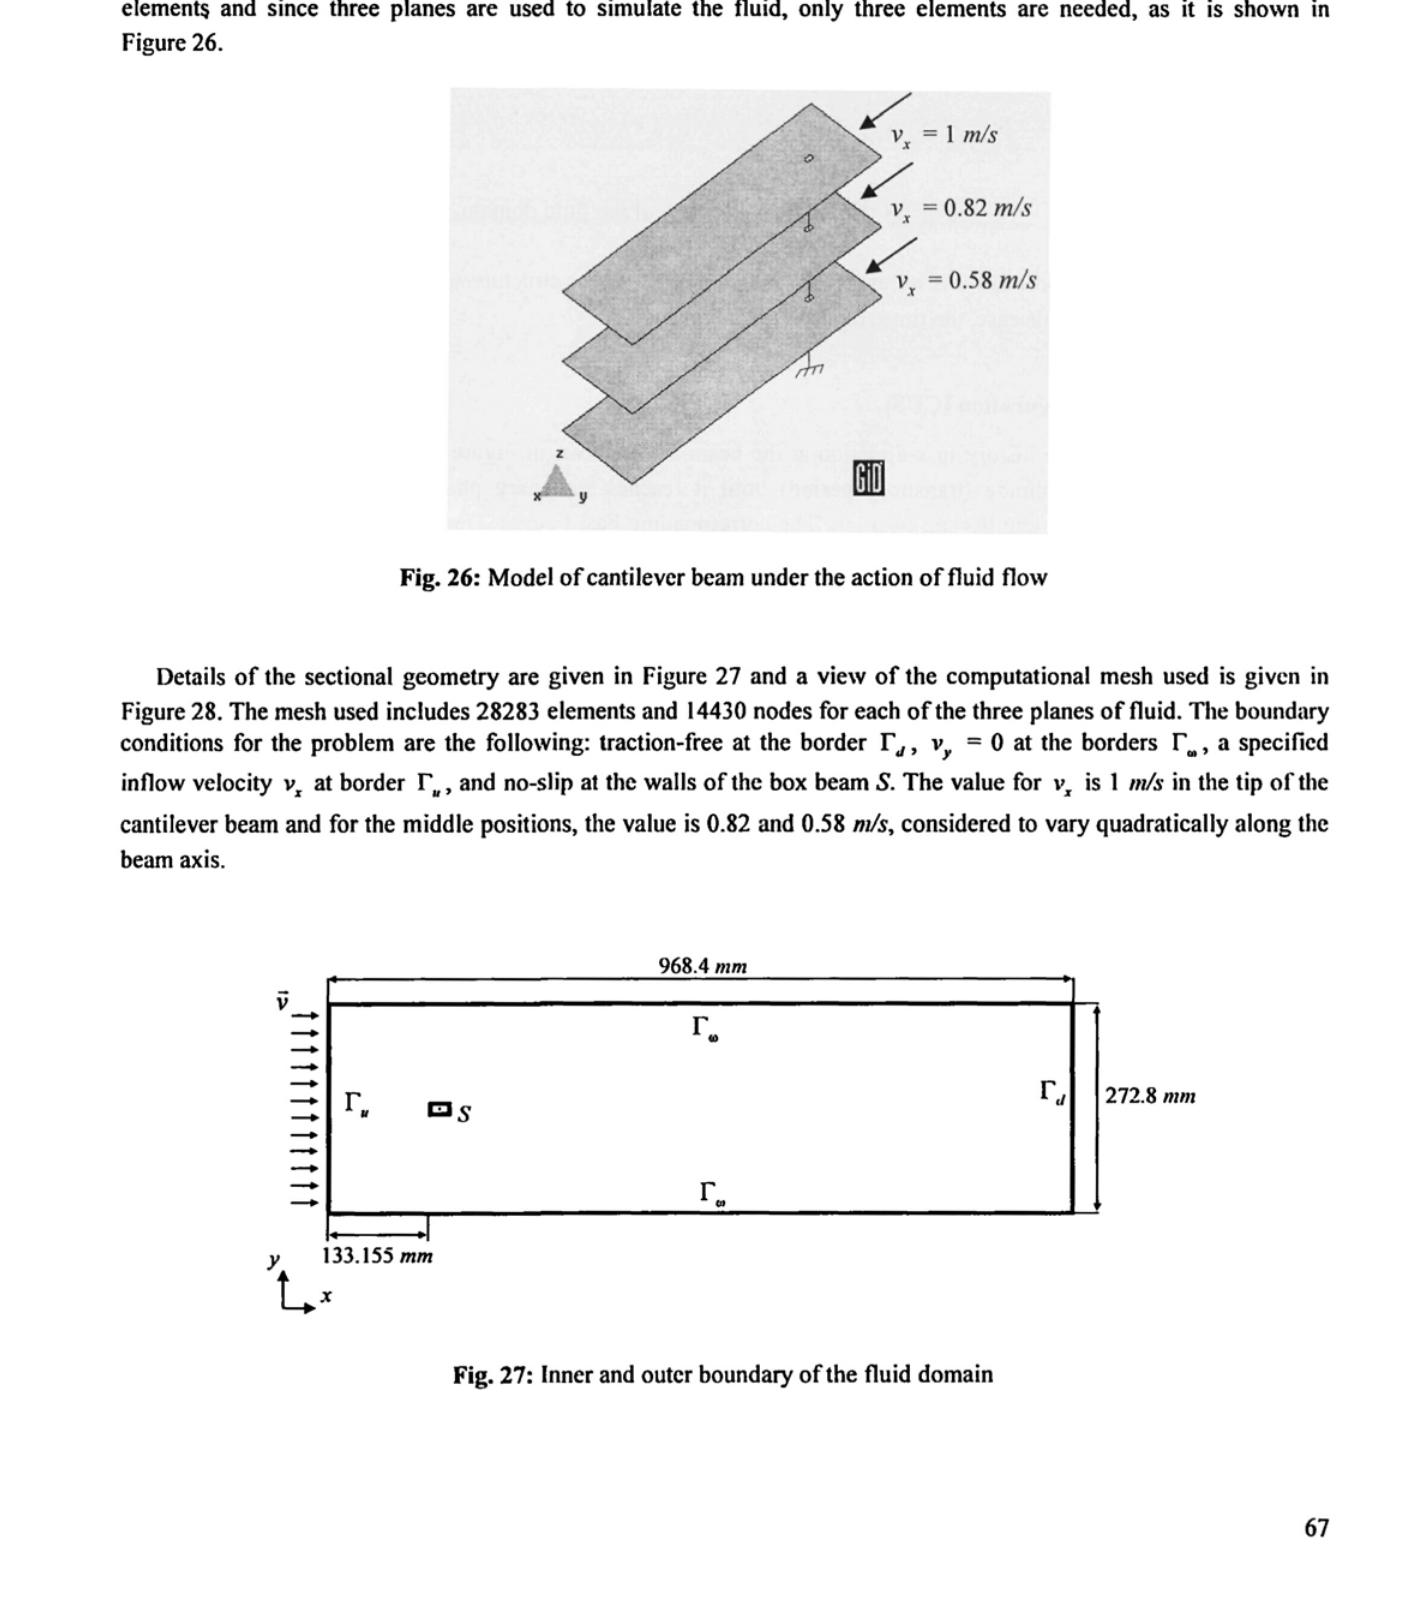
Fig. 27: Inner and outer boundary of the fluid